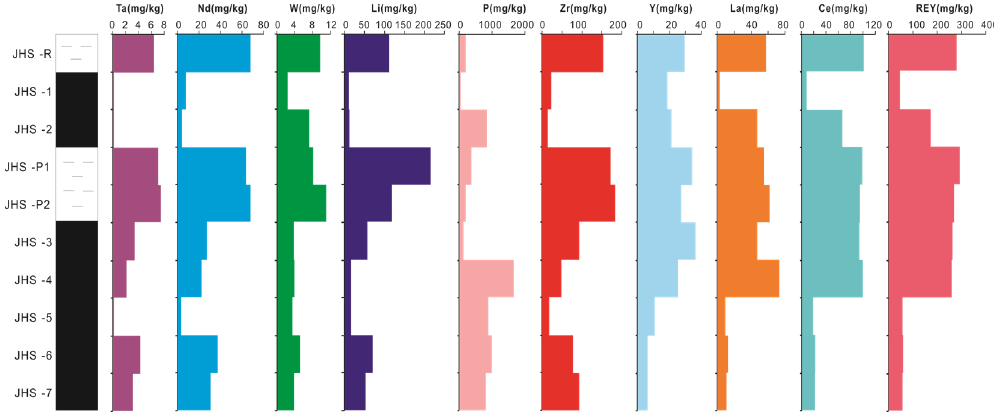
Figure 7. Vertical distribution of elevated elements through coal benches of the Jinhuashan coal mines.